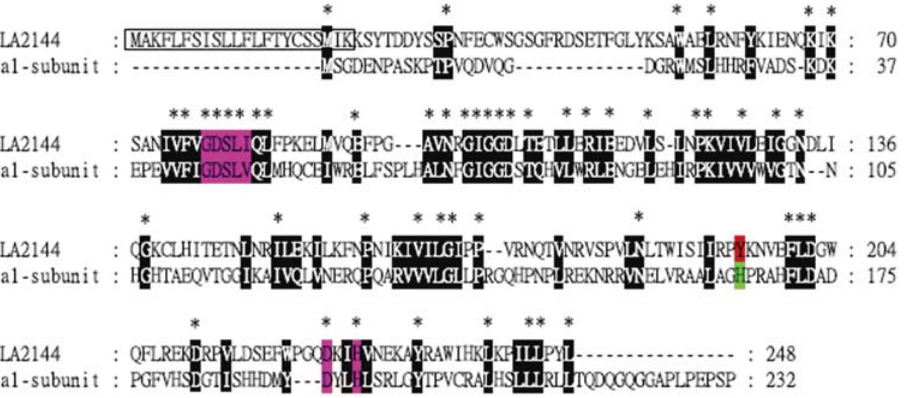
Figure 1. Alignment of the amino acid sequences of LA2144 and bovine PAF-AH isoform I a 1-subunit. The alignment was generated by using ClustalW. Identical and similar amino acids were shaded. Identical amino acids were indicated by asterisks. The conserved motif Gly-Asp- Ser - Leu-Val/Ile, and the enzyme activity sites, Asp and His, were indicated in purple. Hypothetical signal peptide was boxed. Tyr 195 of LA2144 was marked in red, and its relative amino acid at bovine PAF-AH isoform I a 1-subunit was indicated in blue.